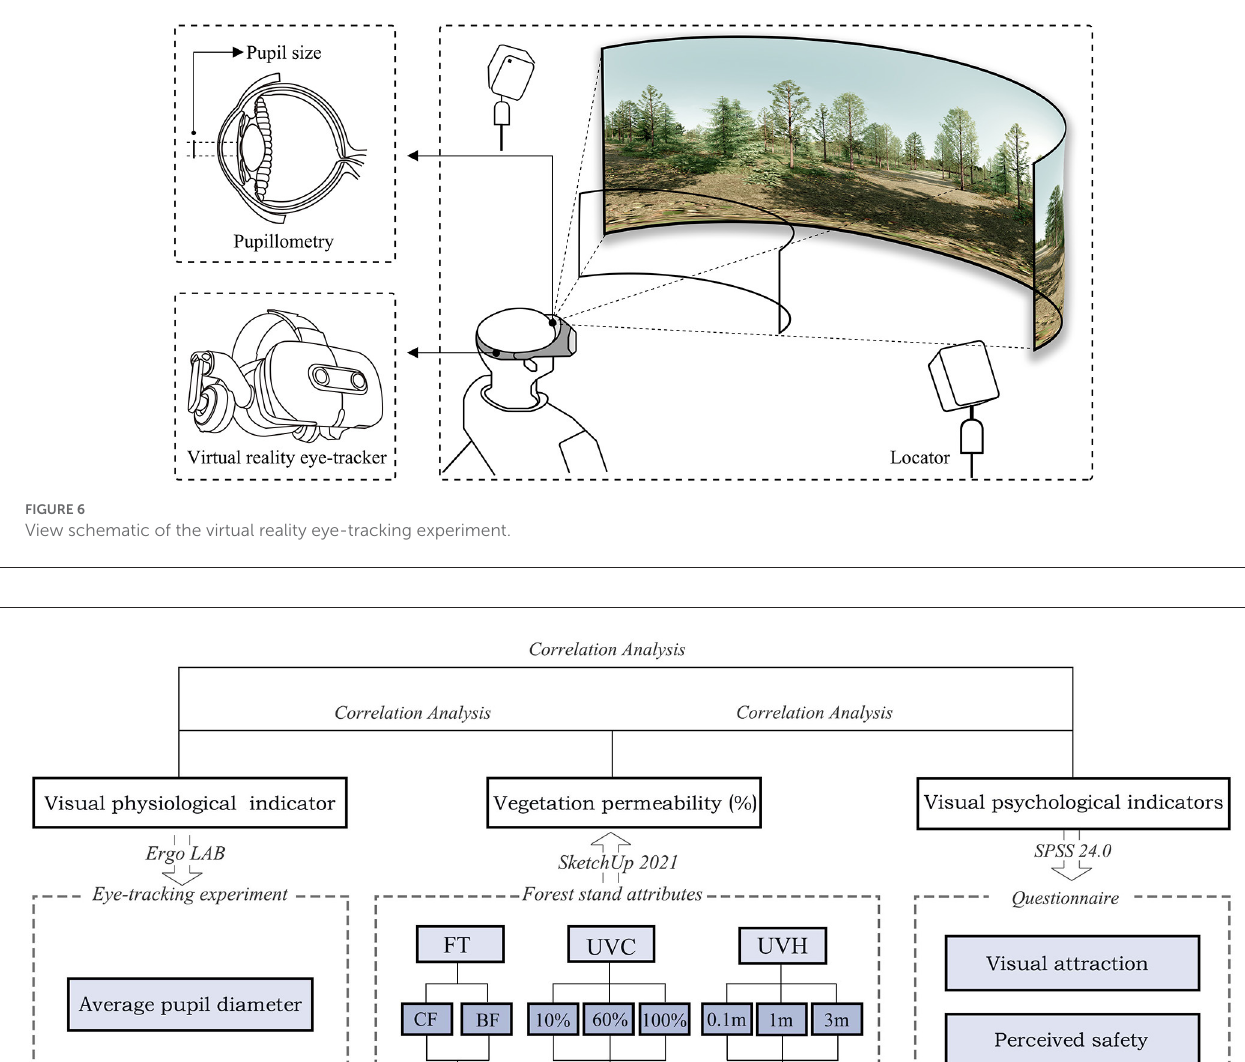
safety separately between each level. Fifth, The Kendall and Spearman rank correlation is used to analyze correlations between vegetation permeability and participants’ visual perception. Partial Eta squared is adopted to calculate the effect size (Figure 7). Significance is established at p < 0.05 ∗ , p < 0.01 ∗∗